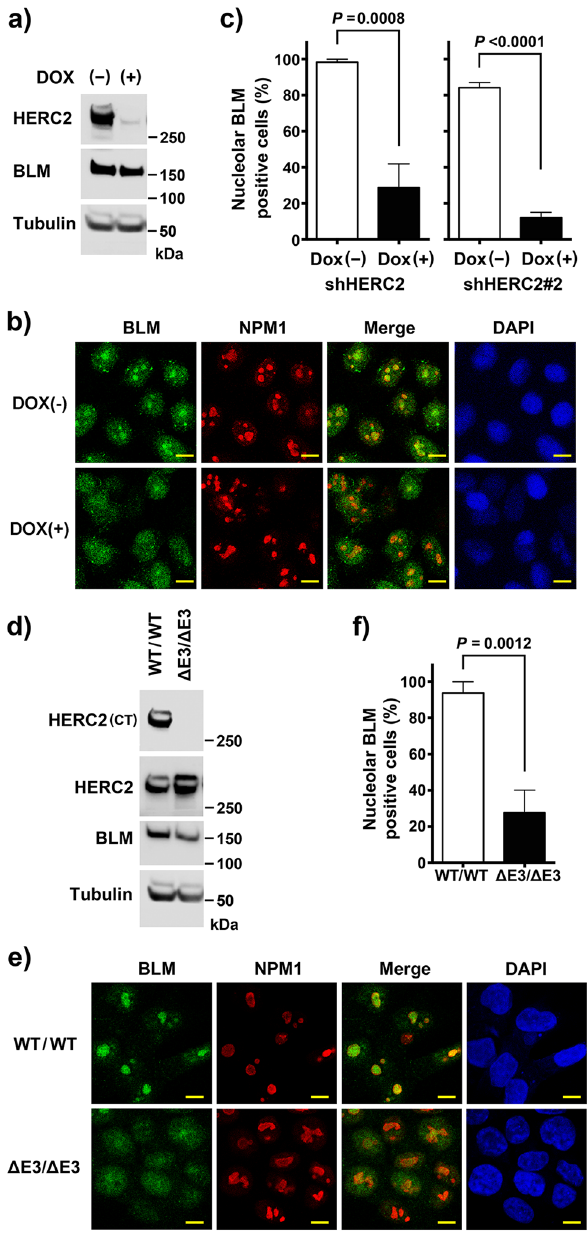
Figure 1. Nucleolar localization of BLM requires HERC2 and its E3 domain. (a,b) HeLa-shHERC2 cells, with or without Dox-mediated induction, were subjected to immunoblotting (a) or immunostain (b) with the indicated antibodies. The nuclei were counter stained with DAPI. Scale bar, 10 μm. (c) Quantifications of the nucleolar BLM positive cell from (b) (left panel), and those from HeLa cells with a different shRNA (shHERC2#2, right panel, see also Supplementary Figure S1) are shown. Error bars, S.D. of three independent experiments, each based on more than 100 cells. Statistical significances was calculated using the Student’s t- test. (d,e) Wild-type or HERC2 ΔE3/ΔE3 HCT116 cells were subjected to immunoblotting (d) or immunostaining (e) with the indicated antibodies. Antibodies HERC2 (CT) and HERC2 recognize residues 4389–4834 and 1781–1974 of HERC2, respectively. Scale bar, 10 μm. (f) Quantification of the nucleolar BLM positive cell. Error bars, S.D. of three independent experiments, each based on more than 100 cells. Statistical significances was calculated using the Student’s t- test. Full-length blots/gels are presented in Supplementary Figure